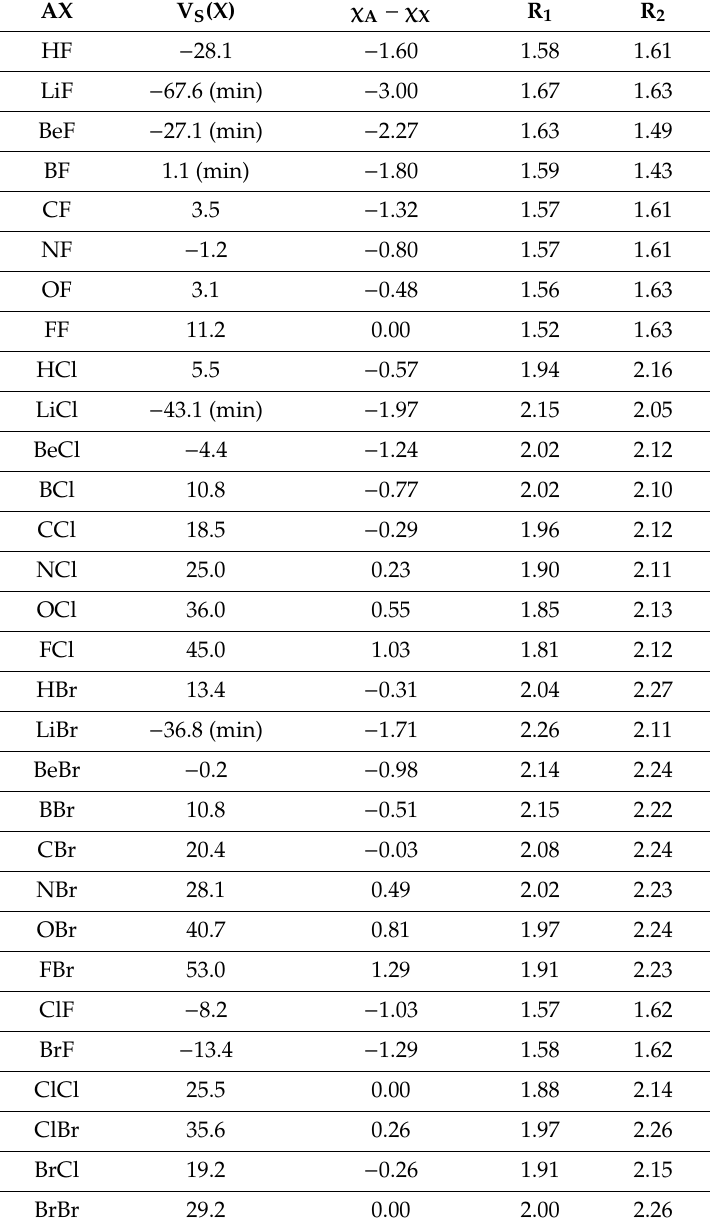
Table 1. Properties of AX diatomic molecules (X = F, Cl and Br). V S (X) is computed maximum or minimum of V S ( r ) on X, on the extension of the A–X bond. The minima are explicitly indicated. χ A − ff erence in electronegativities of A and X. R χ 1 and R 2 are distances from X nucleus to 0.001 au X is di contour, along the extension of the A–X bond (R 1 ) and to the lateral side of X (R 2 ) a . AX V S